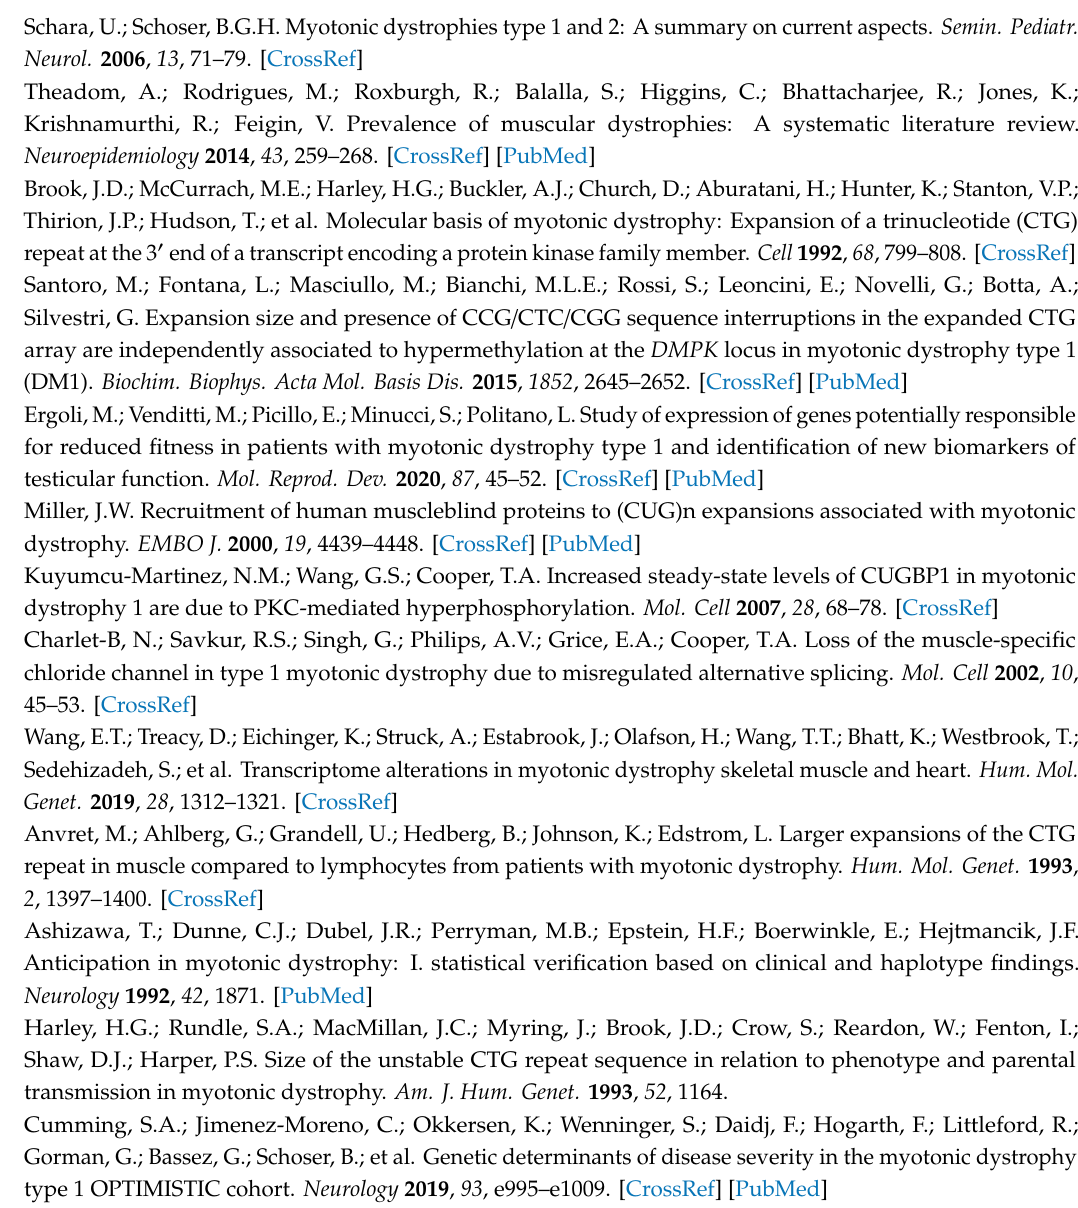
Figure S1: TP-PCR repeat interruptions example; Table S1: Primers and PCR conditions; Table S2: Research